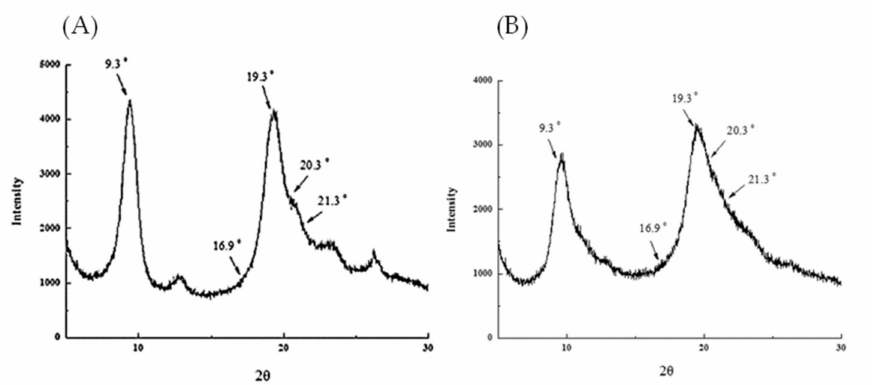
Figure 2. XRD analysis of chitin and chitosan extracted from BSF pupal shell. ( A ) Chitin; ( B ) Chitosan.